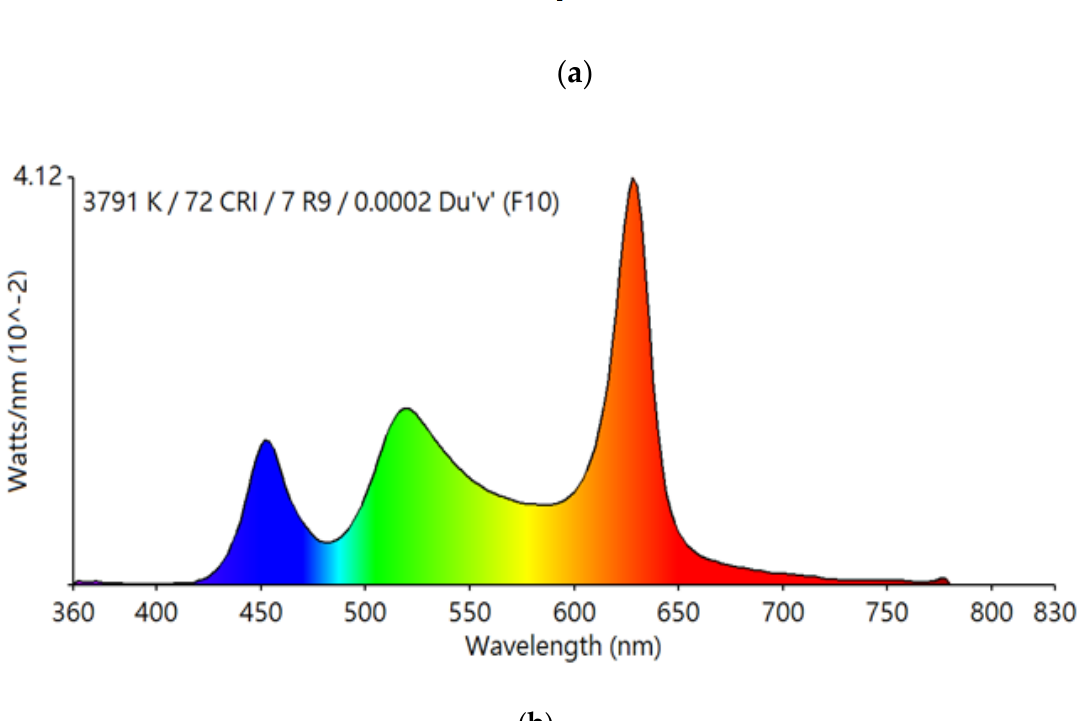
Figure 3. ( a ) Lowest Dynamic CCT lighting spectrum (1900 K); ( b )The highest Dynamic CCT lighting spectrum (3800 K), please refer to Figure 2 for the Dynamic CCT lighting frequency.